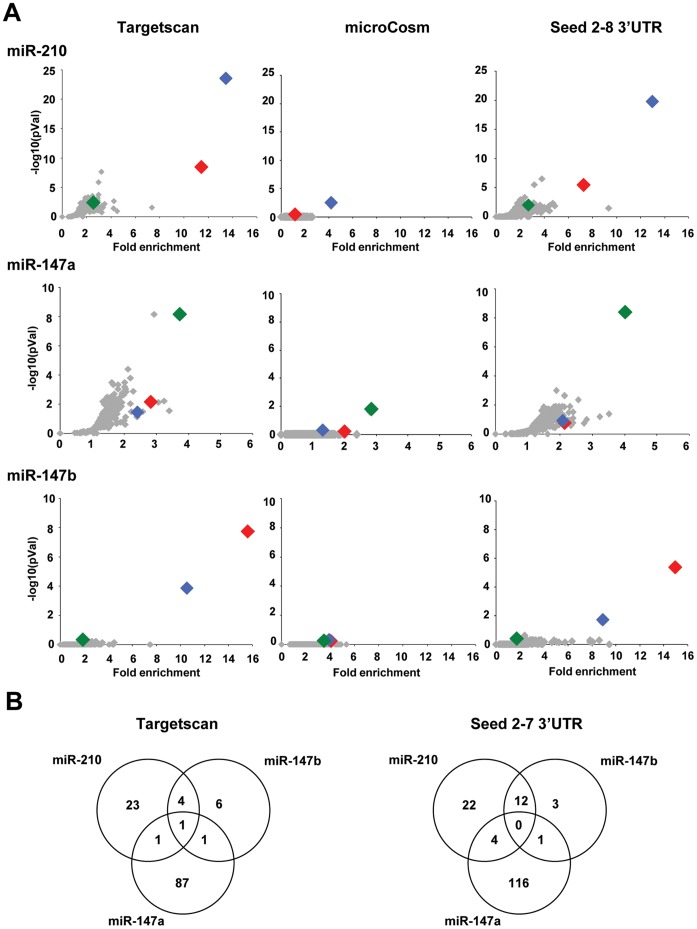
Enrichment of miR-210 and miR-147 family members-predicted targets in the different subsets of modulated transcripts following transfection by each miRNA candidate. A) Graphs adapted from our webtool miRontop [33] showing the significance of the enrichment (represented as –log10 (adjPVal) according to the fold enrichment in experiments of overexpression of miR-210, miR-147a and miR-147b. Enrichment was calculated according to TargetScan, microCosm or a 2–8 seed search in 3′UTR. On each panel, miR-210, miR-147a and miR-147b are highlighted as blue, green and red dots, respectively. B) Venn diagram summarizing the predicted common targets of miR-210 and miR-147 family members using the combination of transcriptomic data and different bioinformatics prediction tools: TargetScan and a search of a 6 nt complementary seed 2–7 sequences in 3′UTR. Cut offs used for the selection of down-regulated transcripts: log2Average>8; logFC<-0.5 and Adj.pVal<0.05.